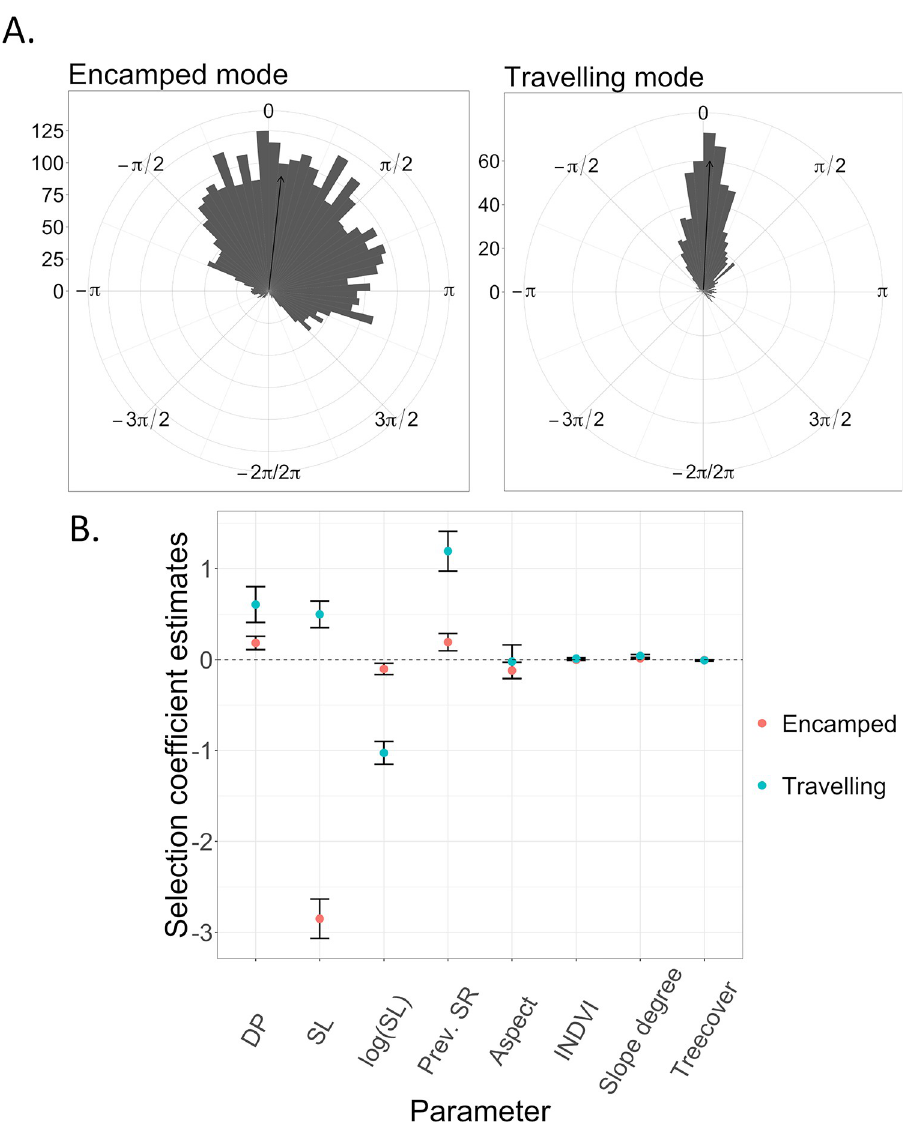
Fig 4. A. Distribution of directional bias (in radians) towards summer range visited in 2011 by mule deer in Medicine Bow National Forest, while they were migrating during spring 2012, according to the mode of movement estimated by the HMM-SSF at each step (either encamped or travelling). Estimated mode of movement was based on the conditional probabilities of being in encamped and travelling mode at each step, truncated to 0–1 using a 0.50 threshold. The arrows indicate the average directional bias. B. State-specific selection coefficient estimates from the HMM-SSF of different covariates influencing mule deer spring migration. DP = directional persistence (cosine), SL = step length, log(SL) = natural logarithm of step length, Prev. SR = directional bias towards previously visited summer ranger (cosine).